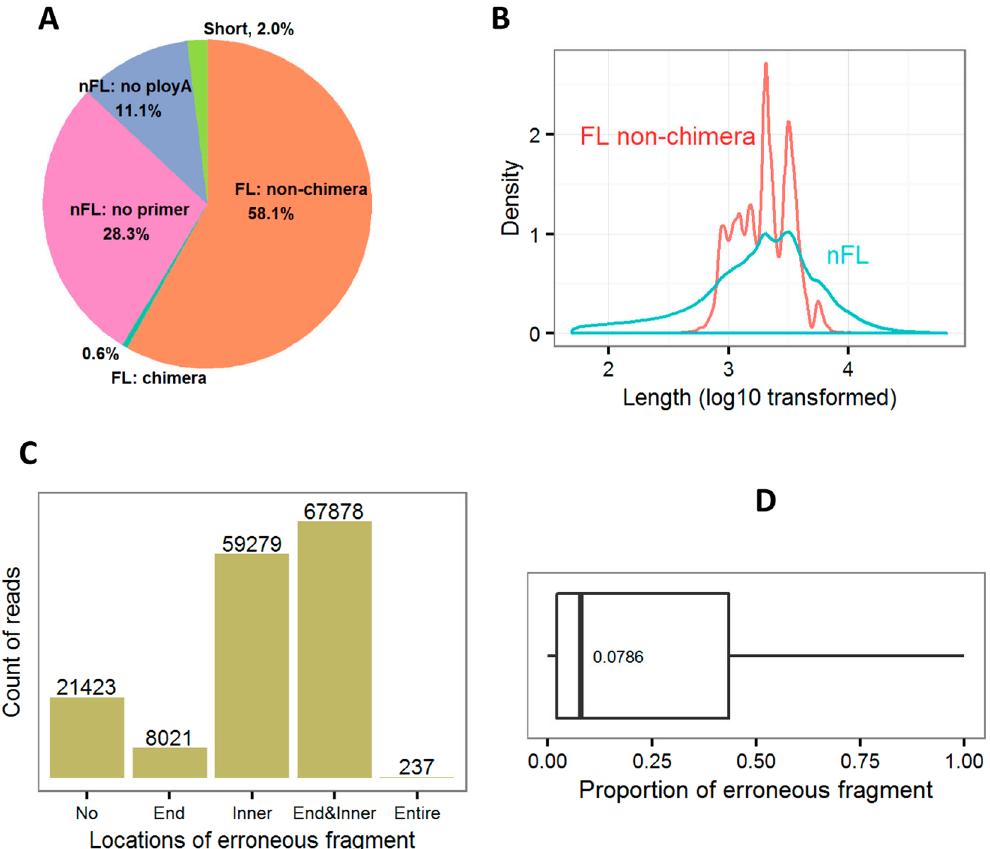
Figure 1. Classification of ROIs and error correction. All ROIs were first classified ( A ) and produced FL and nFL isoform sequences with differential patterns of length distribution ( B ). After the error correction by Illumina short reads, ROIs were categorized according to the occurred locations of erroneous fragments ( C ), including the absence (No), terminal ends (End), inner positions (Inner) and the entire sequences (Entire). Finally, we investigated the length proportion of erroneous fragment relative to raw ROIs ( D